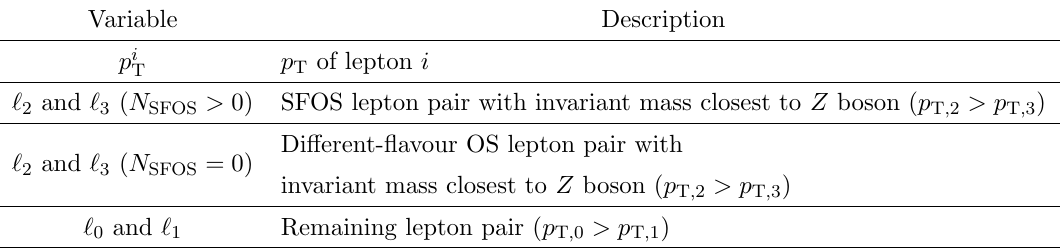
Table 10 . Description of the notation used in the four lepton analysis.